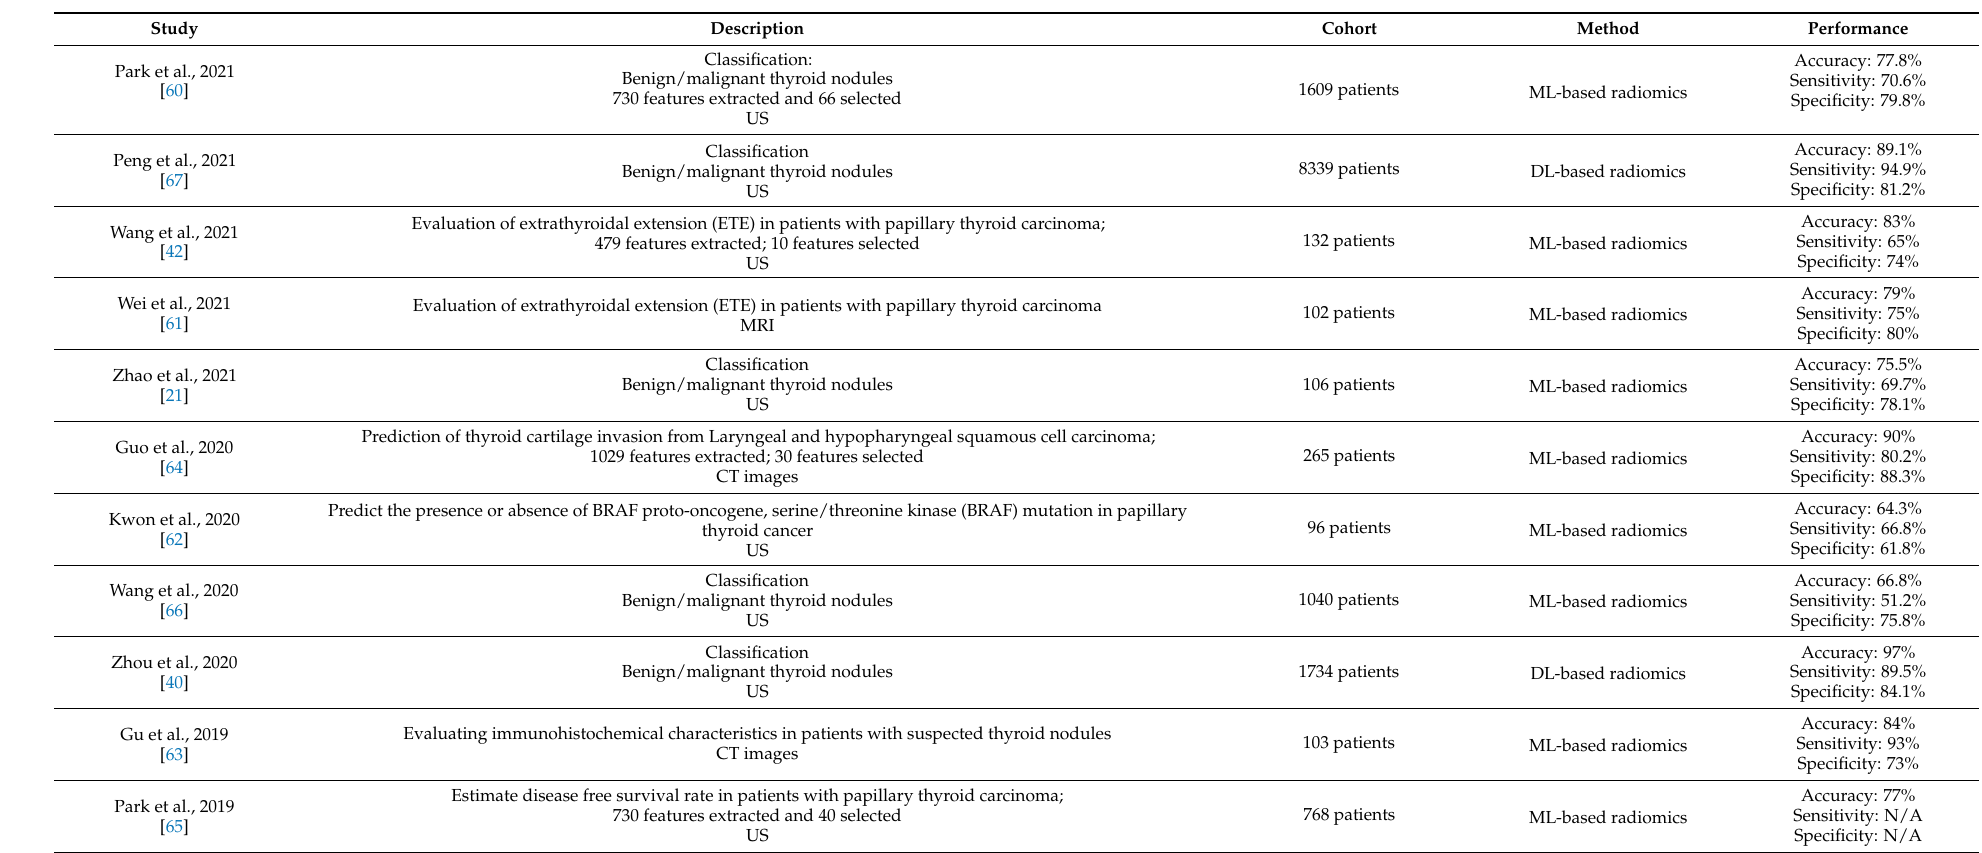
Table 3. Radiomics